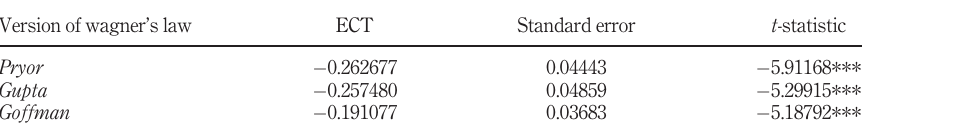
Table 8. ECT for the